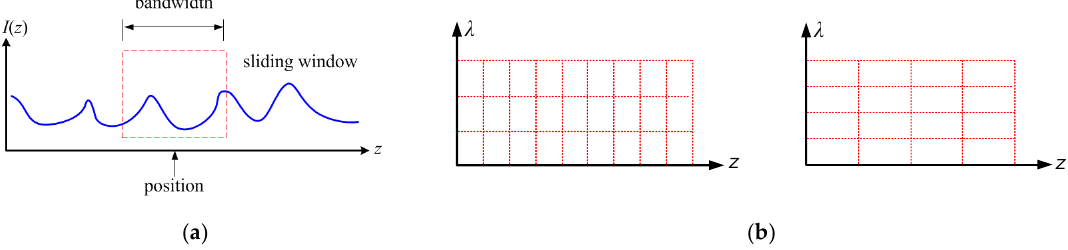
Figure 2. Demodulation of OFDR signal to achieve the distributed sensing information: ( a ) sliding windows in the spatial domain; ( b ) comparison of short time Fourier transformation’s (STFT’s) spatial and spectrum resolution, left has better spatial resolution and right has better wavelength resolution.